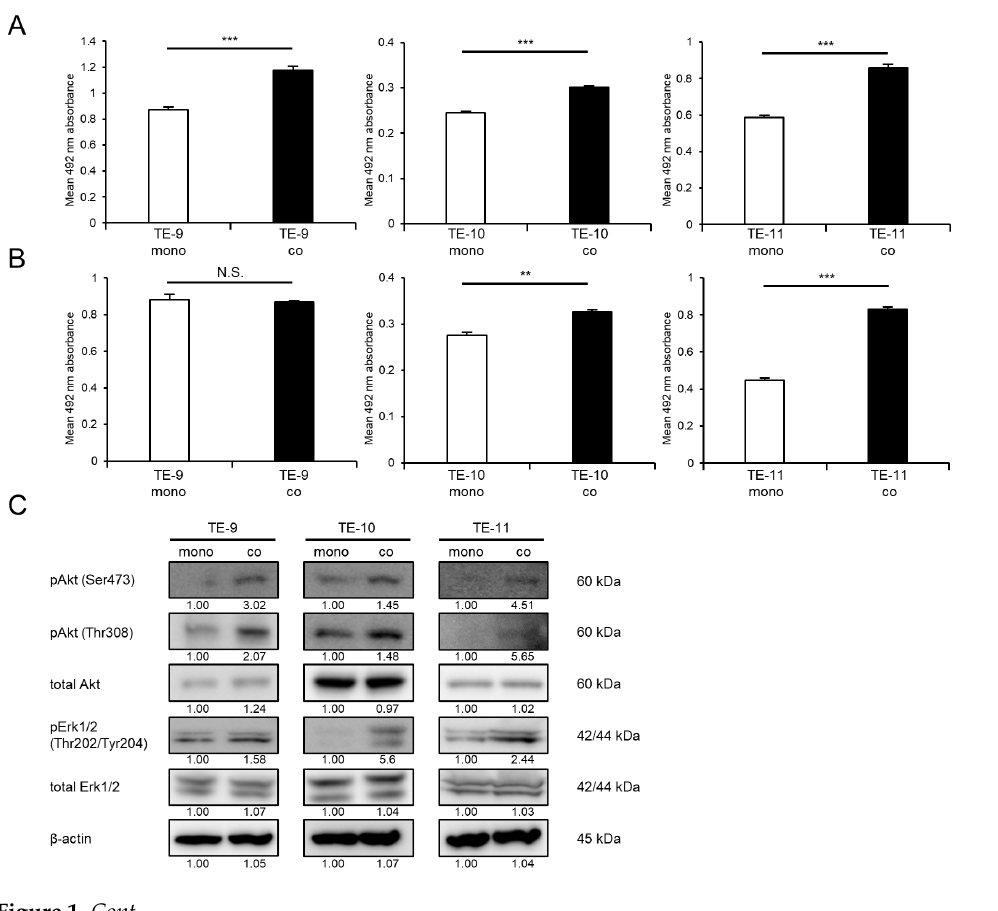
Figure 1. Effects of direct co-culture with macrophages on ESCC cell lines. ESCC cells were directly co-cultured with macrophages for 2 days and then separated from macrophages. ( A , B ) Survival assays ( A ) and growth assays ( B ) were performed to investigate the effects of direct co-culture. The three graphs compare the survival and growth of TE-9, -10, and -11 cells co-cultured with macro- phages with those of monocultured TE-9, -10, and -11 cells, respectively. ( C ) Western blot analyses were performed to investigate the signaling pathways activated in TE-9, -10, and -11 cells by direct co-cultur e with macrophages. β -actin was used as an internal control. The expression level was nor- malized using ImageJ software, and the relative value was set as 1.00 for monocultured ESCC cells. ( D ) The expression levels of IL7R mRNA in TE-9, -10, and -11 cells monocultured and co-cultured with macrophages were confirmed by qRT-PCR. GAPDH was used as an internal control. ( E ) The expression levels of IL-7R protein in TE-9, -10, and -11 cells monocultured and co-cultured with macrophages were confirmed by Western blot analyses. β -actin was used as an internal control. The expression level was normalized using ImageJ software, and the relative value was set to 1.00 for